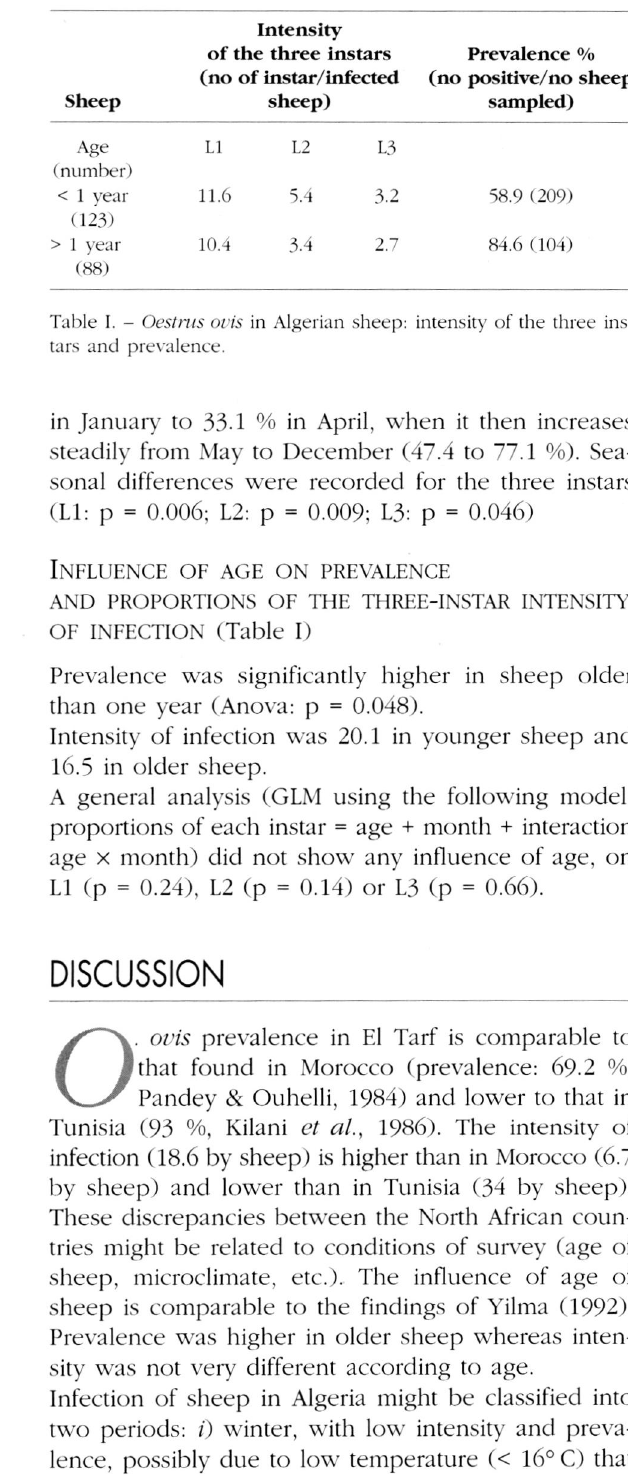
OF INFECTION (Table I)